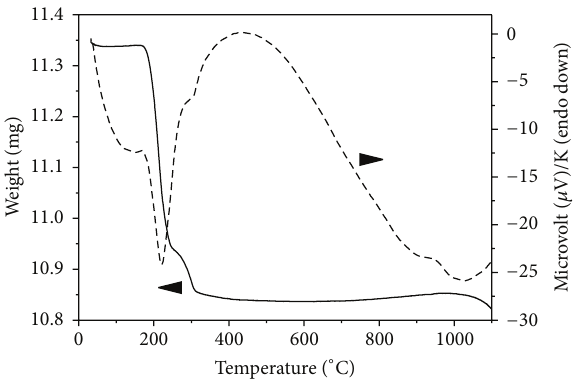
Figure 1: TG/TDA analysis of mixed precursor for Cd 2 SnO 4